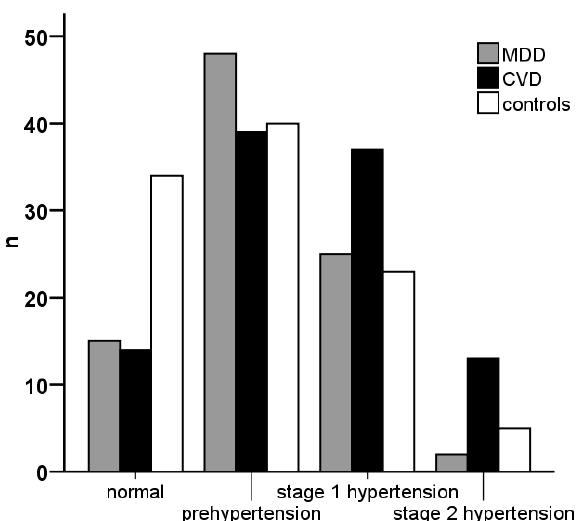
Figure 1. JNC 7 classification of blood pressure. Classification of blood pressure baseline values according “The Seventh Report of the Joint National Committee on Prevention, Detection, Evaluation, and Treatment of High Blood Pressure” (JNC-7) [28] showed significantly different distribution of hypertension categories in major depressive disorder (MDD) and cardiovascular disorder (CVD) patients as well as in healthy controls (n = number of subjects in either group). Table 1. Demographic, clinical, and medical characteristics of samples 1–3 including psychiatric ratings, vital signs, and selected classical cardiovascular risk factors. Vital signs as well as classical cardiovascular risk factors and behavioral variables are indicating an elevated cardiovascular risk in MDD.